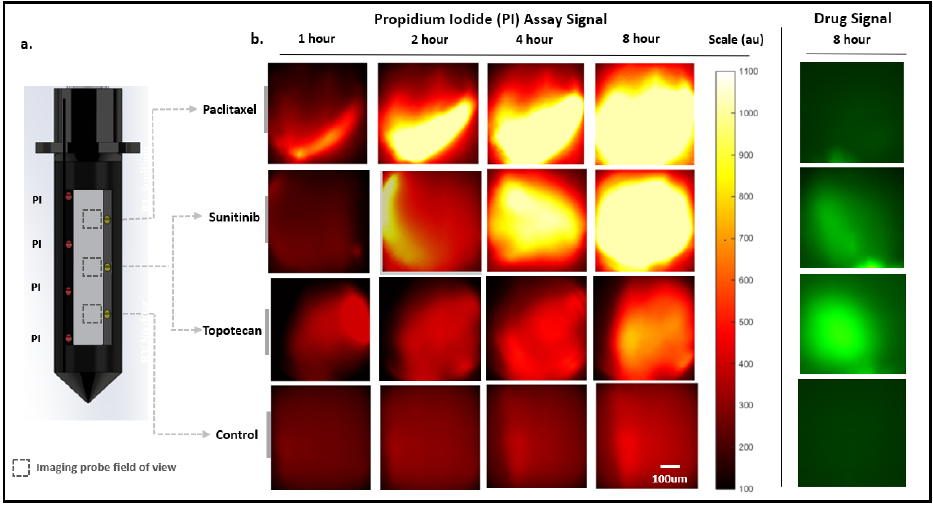
Figure 4. Miniaturized 2-color microscopy (M-2CFM) over 8 h in a live murine MC38 tumor. ( a ). Microdevice drug and assay loading diagram. The three distinct drug release sites spaced 1.1 mm apart contain Paclitaxel ( n = 5), Sunitinib ( n = 3) or Topotecan ( n = 2), and Control (inert polyethylene glycol, PEG) ( n = 5). Propidium iodide (PI) assay is loaded and released from four reservoirs located on the opposite side of the microdevice optical window. PI diffuses equally into all drug-exposed tissue regions (dotted boxes), which can be individually imaged. ( b ). M-2CFM fluorescent imaging of each drug-exposed tissue region in red (assay) and green (drug) channels over 8 h.